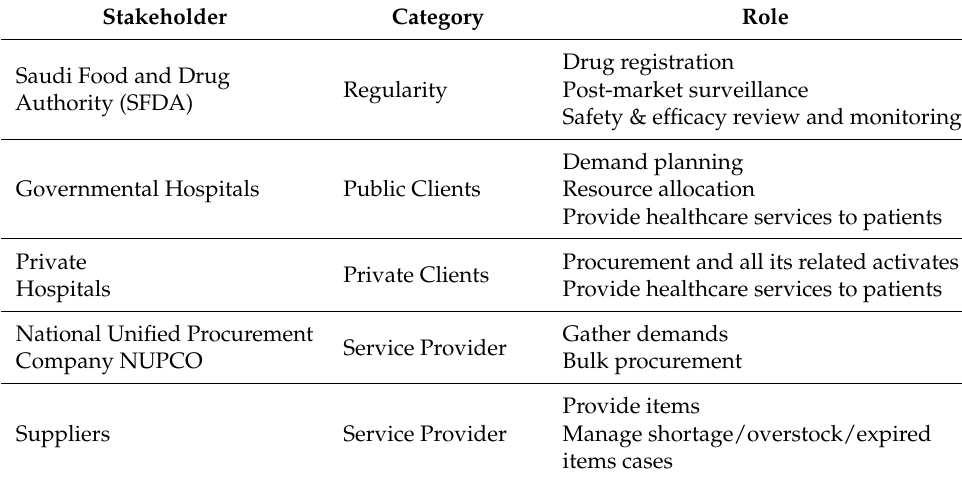
Table 2. Description of the main stakeholders roles.